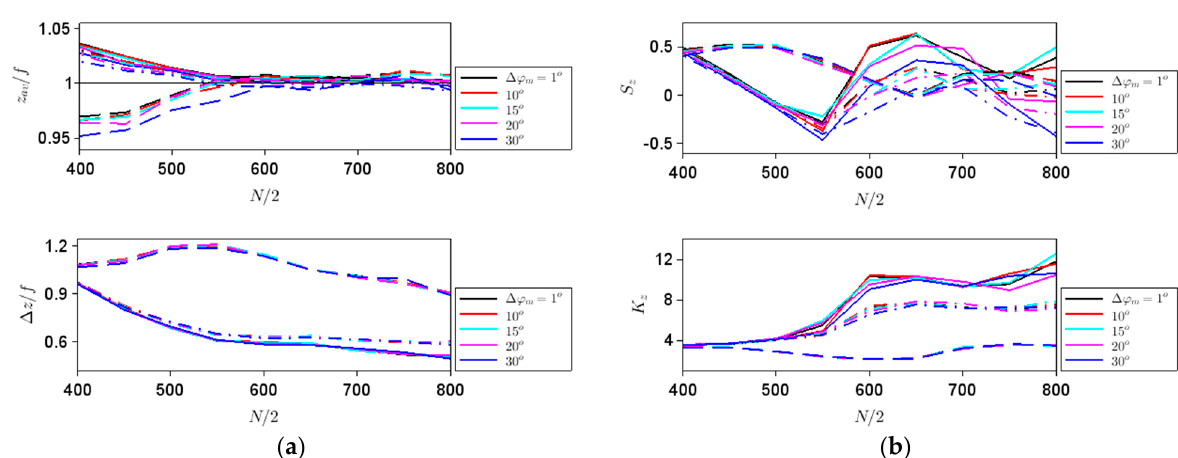
Figure 8. Dependence on the aperture size of ( a ) the transverse longitudinal position and spatial extent of the focalized beam and ( b ) of S z and K z for different phase steps indicated in the legend and for θ = 5° (solid line), 7.5° (dashed–dotted line) and 10° (dashed line).